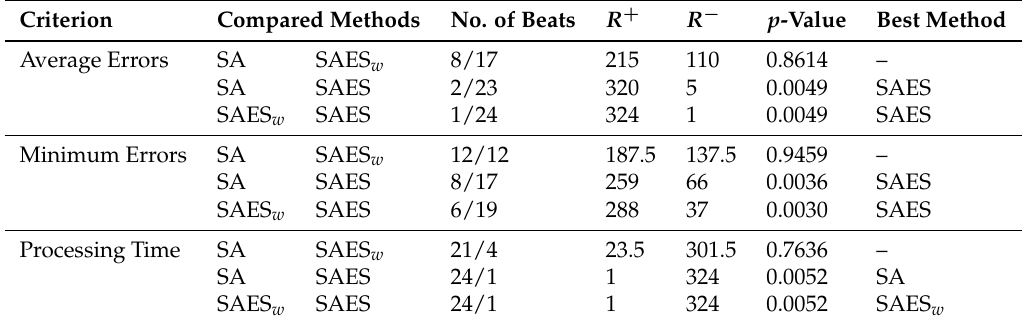
Table 6. Wilcoxon rank-sum test for the results of SA methods using the hard test functions.